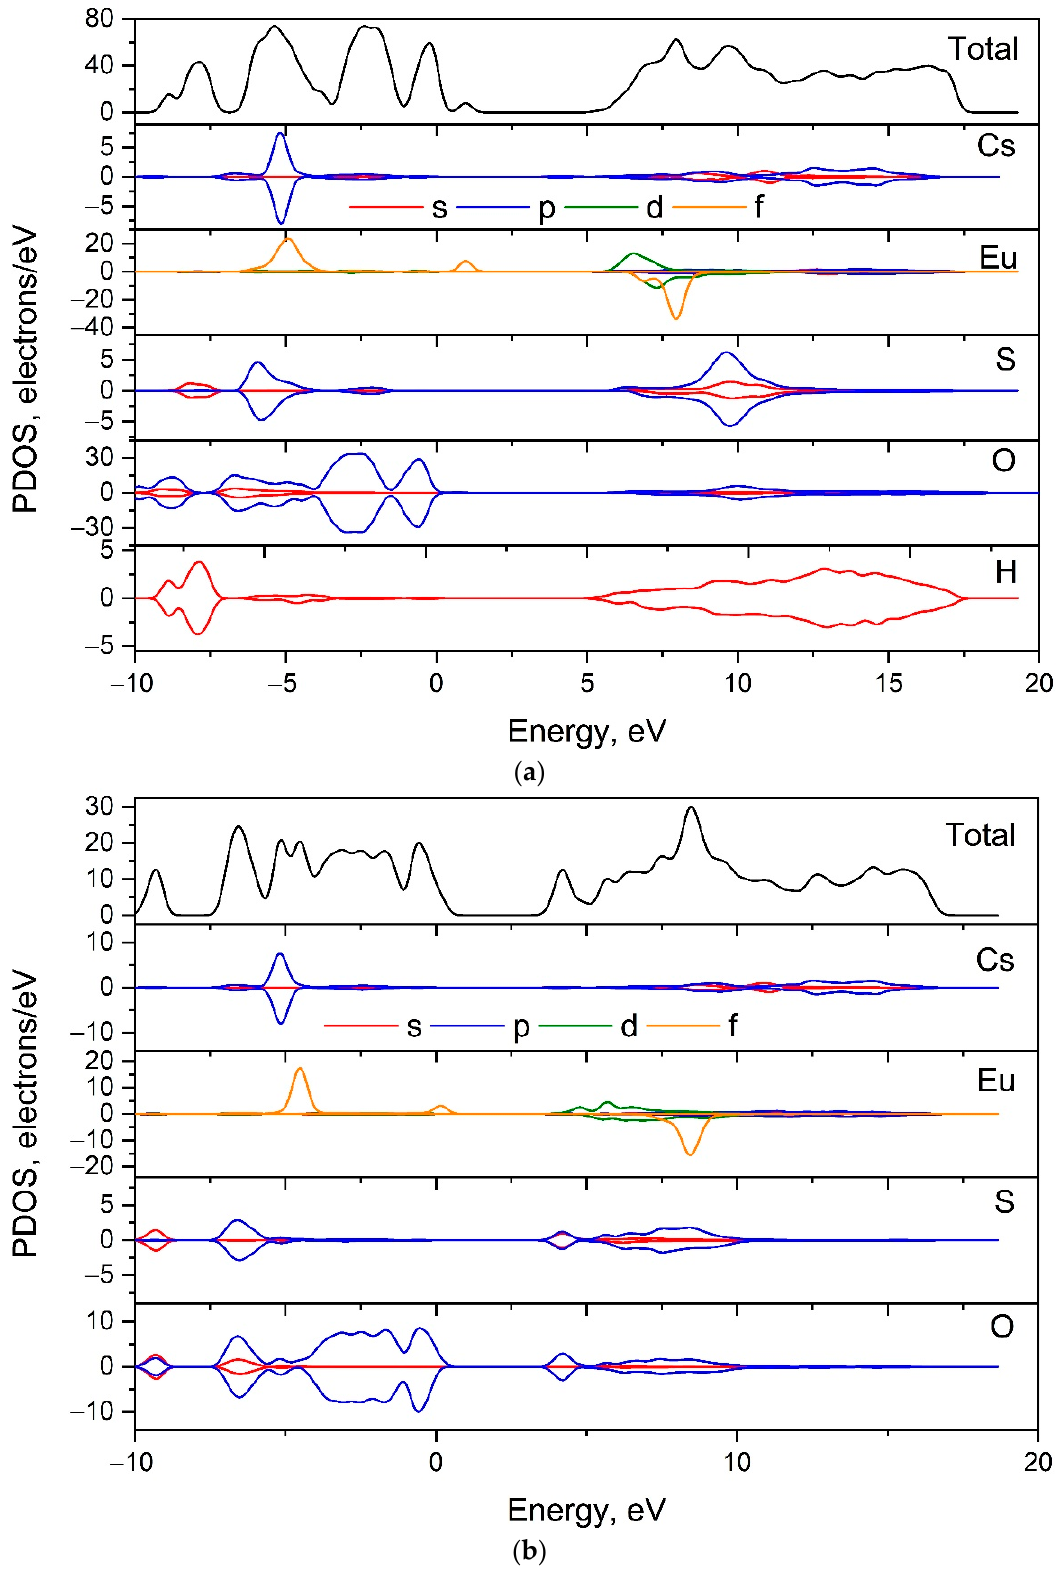
Figure 10. Electronic partial density of states in ( a ) [CsEu(H 2 O) 3 (SO 4 ) 2 ]·H 2 O and ( b ) CsEu(SO 4 ) 2 .